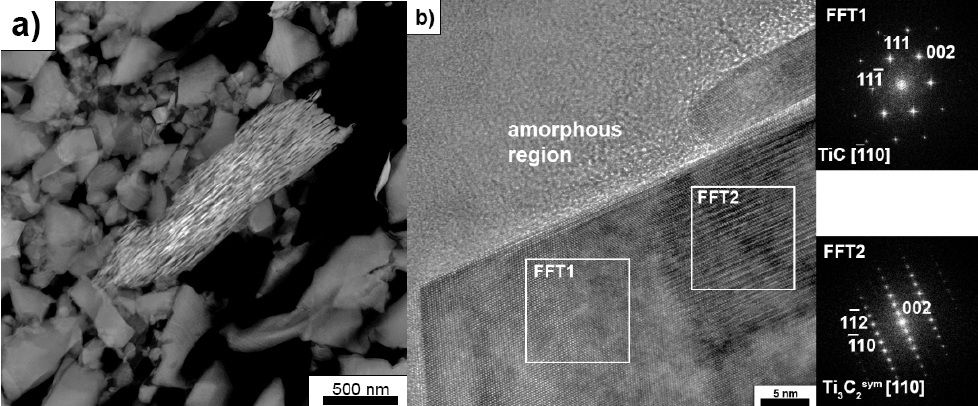
Figure 7. Transmission electron microscopy (TEM) analysis of SiC–C–B–Ti 3 C 2 powder after annealing at 1600 °C: ( a ) Disordered carbon structures, ( b ) high-resolution transmission electron microscopy (HRTEM) image and fast Fourier transform (FFT) pattern of DCS.